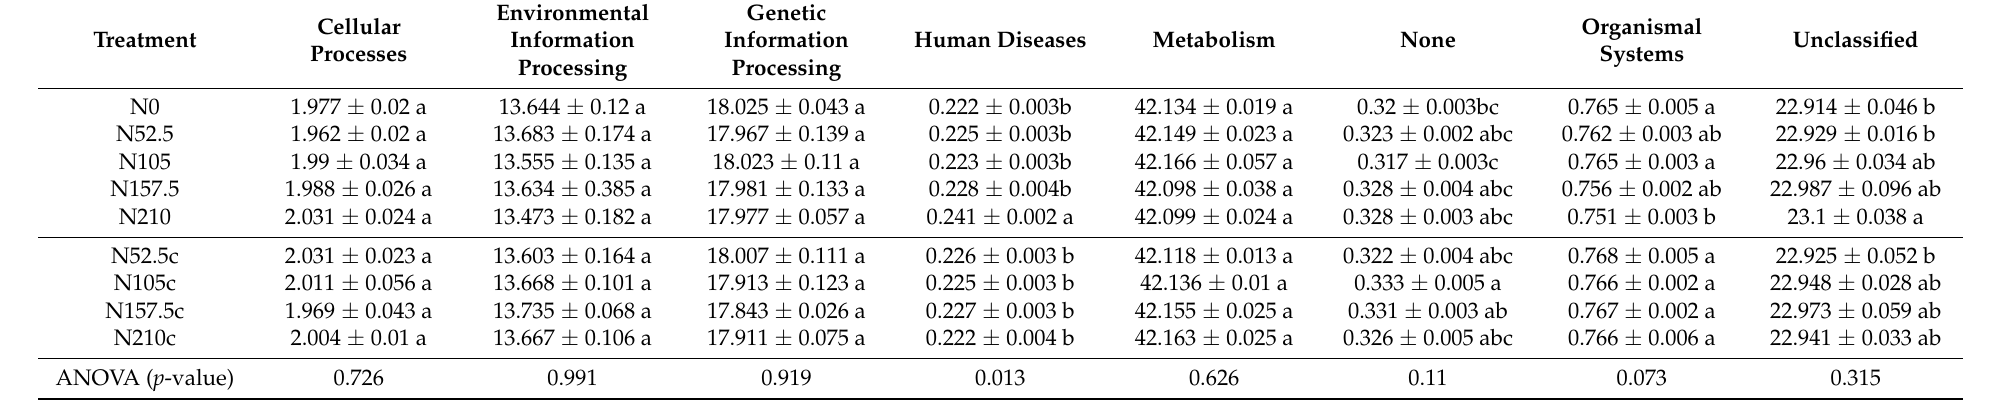
Table 1. The soil bacterial communities predicted functions related to the first level of the KEGG pathway as affected by N fertilization.